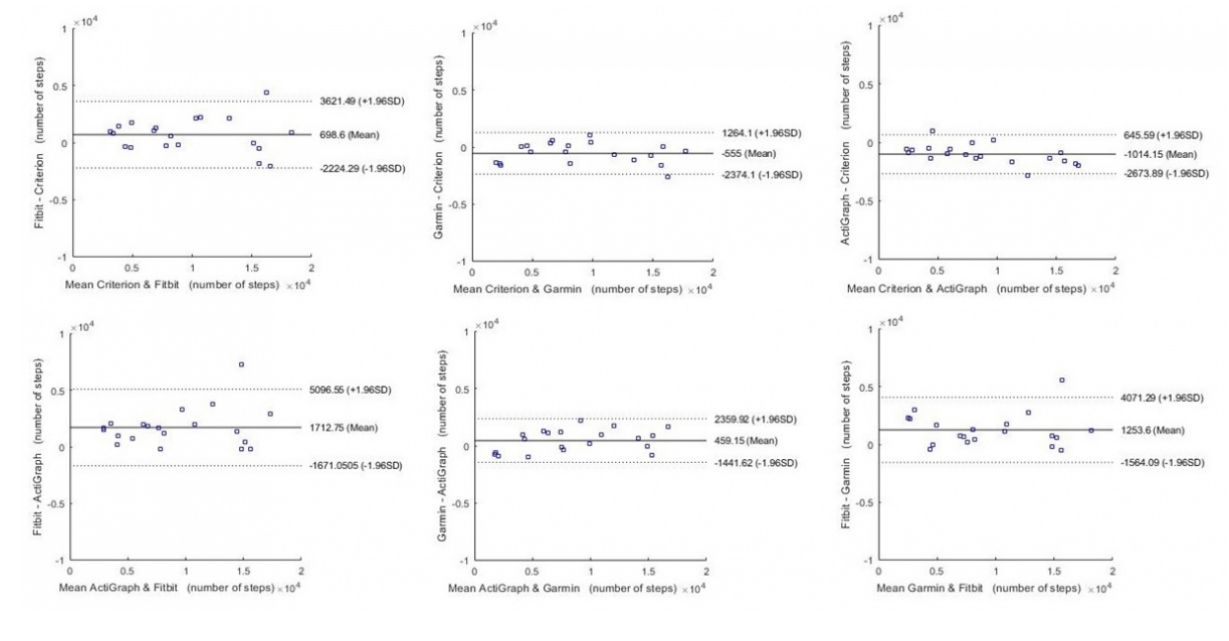
Figure 3. Bland-Altman plots for steps.